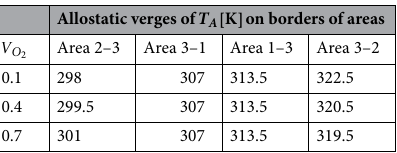
Table 4. Estimated allostatic verges of ambient air temperature T A [ K ] on the borders of areas 1, 2 and 3 for selected values of V O 2 .